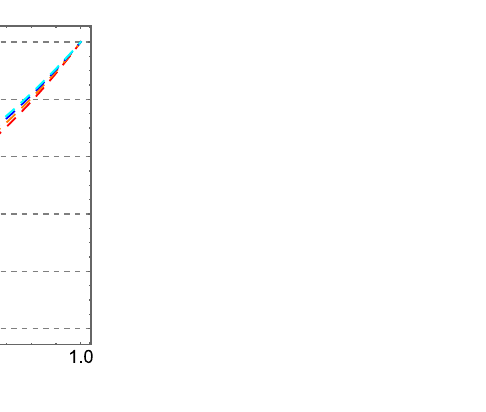
Figure 12. Impact of Eckert number Ec on temperature